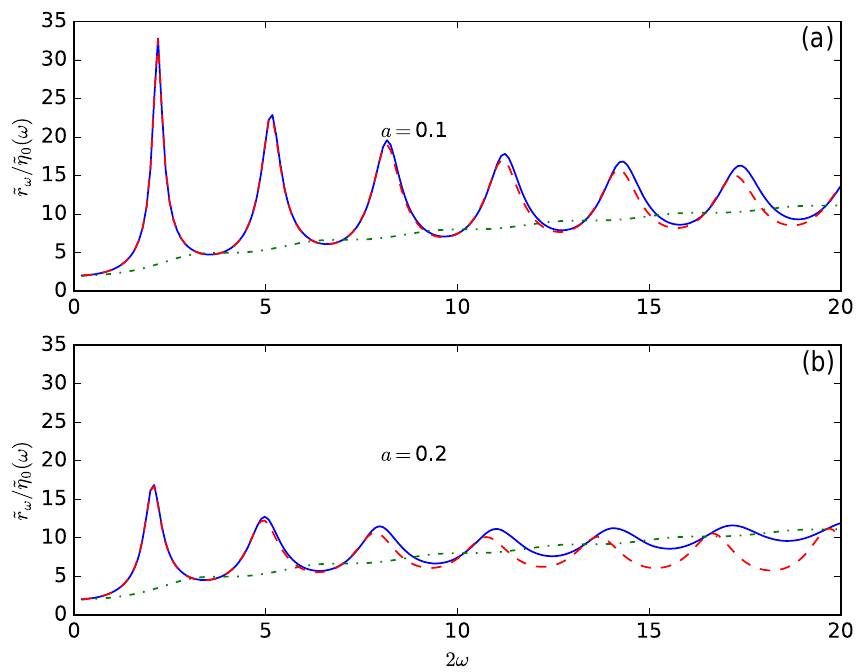
Figure 8. The maximum run-up normalized to the amplitude of the incident wave for the standing wave case for two different channel half-width values. The continuous blue curves are computed using the integral equation, and the red broken curves are obtained from the conformal mapping (see Eq. 48). The green dotted–dashed curve is the maximum run-up for the infinitely wide channel. In panel (a) the half-width of the sloping channel is 0.1, and in panel (b) the half-width is